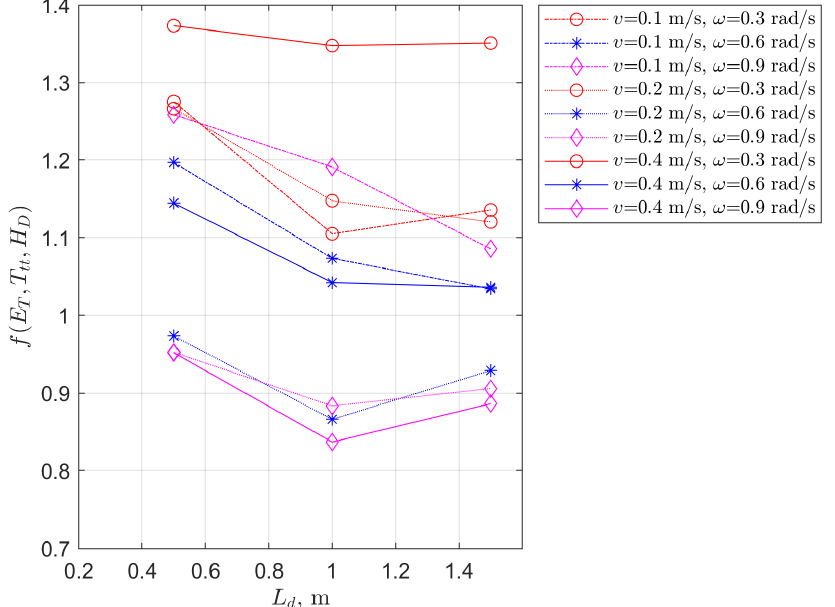
Figure 23. Cost function vs. look ahead distance for selected values of the linear speed and maximum angular rate—track